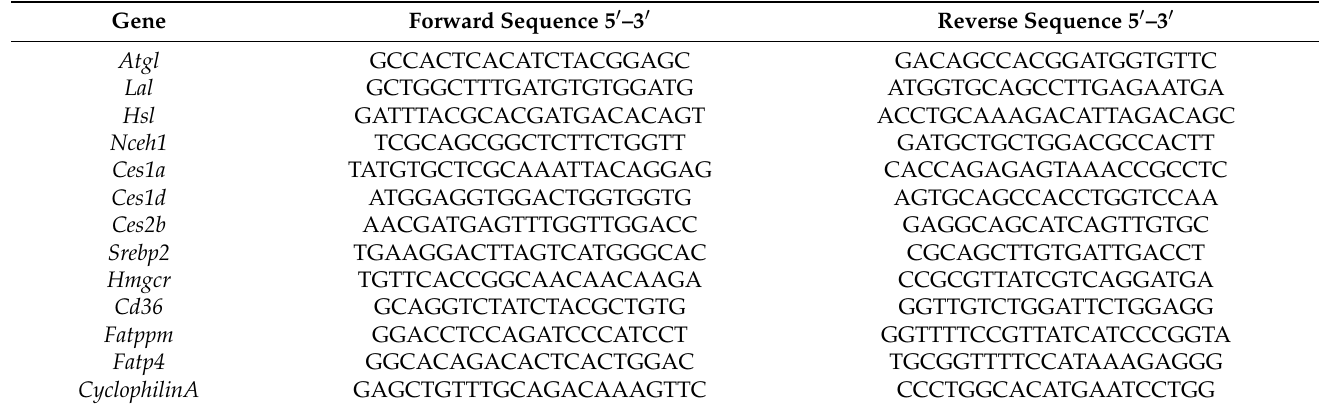
Table 1. Primers for real-time